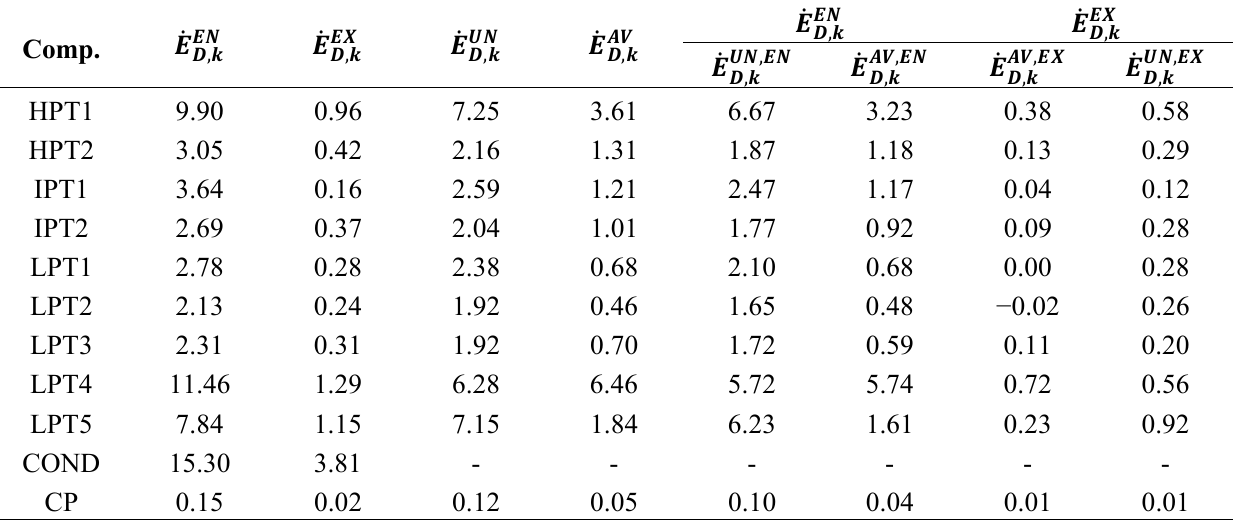
Table 5. Results of advanced exergetic analysis at the component level (Unit: MW).